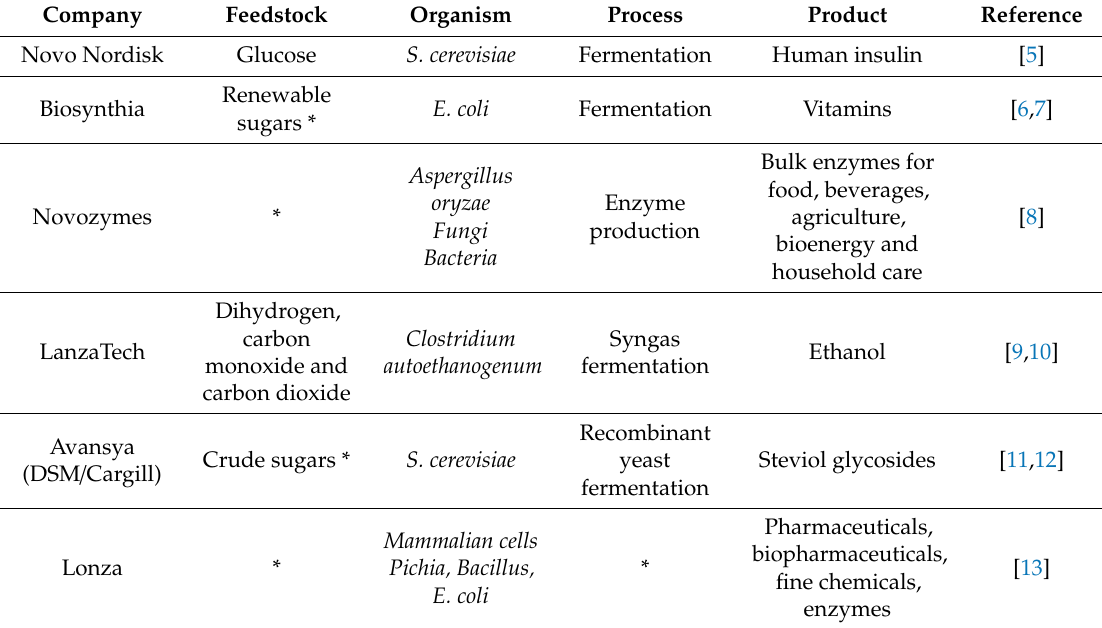
Table 1. Biotechnological processes running at industrial